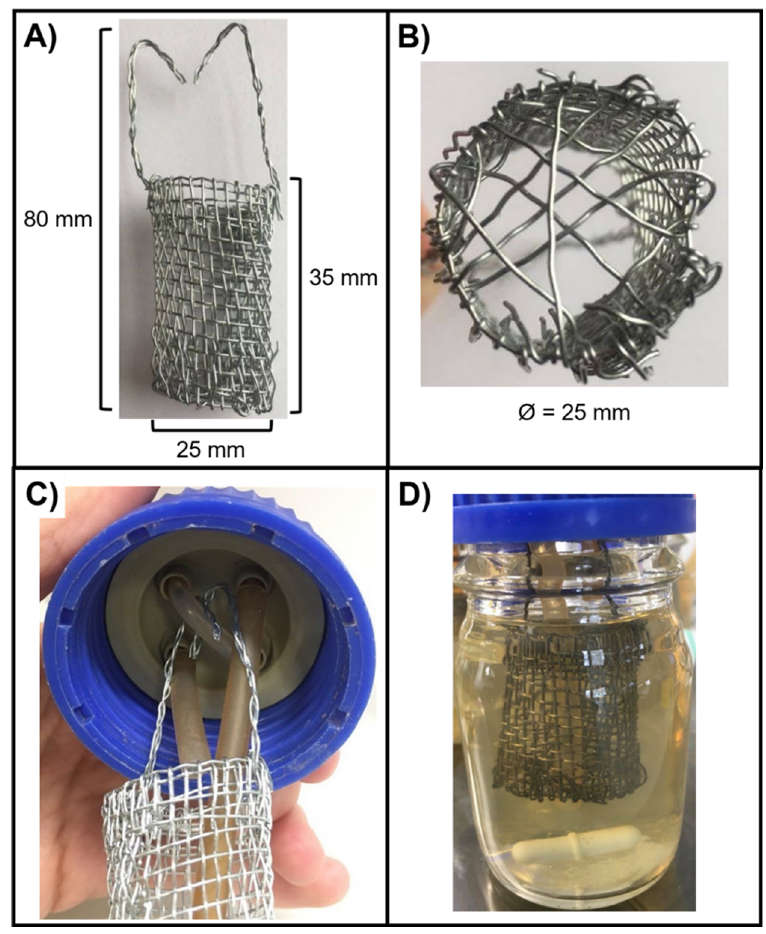
Figure 2. Container for culturing biofilms under continuous-flow conditions. The biofilm container constructed from stainless steel gauze for this study. Biofilm containers consisted of a cylinder, 35 mm in length and 25 mm in diameter ( Ø ), connected to two stainless steel arms (45 mm in length), which suspend the container from the HPLC screw-port lid. (A) Side view of the container with dimensions. (B) Bottom view of the container. Single strands of stainless-steel wire were threaded across the bottom of the container to form a mesh and prevent the biofilm substratumfromfallingthrough.Asmallgap(~3mm Ø )wasalsoincludedfortheoutlettubetobethreadedthrough to allow the removal of culture media during incubation. (C) View of the 4-port HPLC screw cap lid. The left port is the media inlet, the rightport is the media outlet and the two remaining ports arethreaded with asingle piece of rubber tubing(1.5mmbore)toholdthearmsofthemeshcontainer.(D)Thebiofilmcontainer insitu intheassembledsetup. Note that the container is completely submerged in the growth medium but is separated from the magnetic stir bar to prevent interference with the continual stirring of the culture